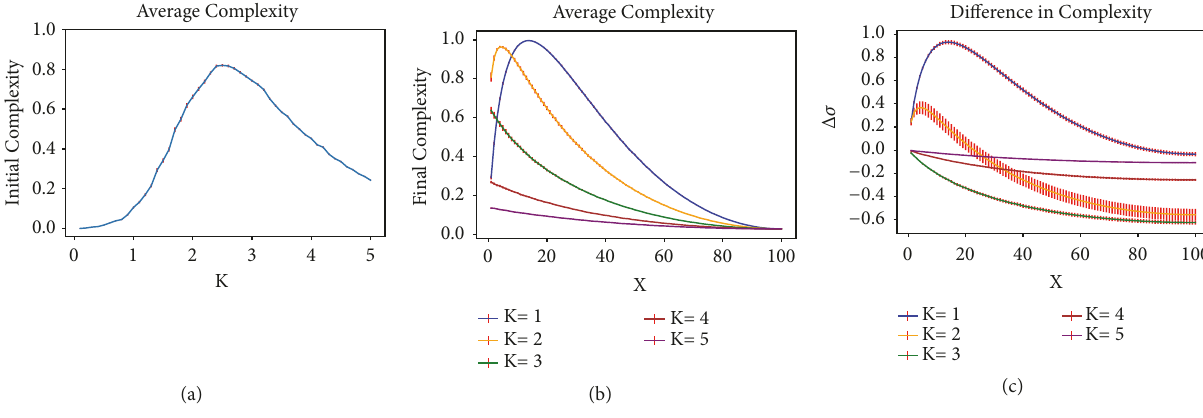
Figure 4: Initial and final complexity for 𝐾 = 1, 2, 3, 4, 5 with 𝑁 = 100. The error bars represent the standard error of measurements for 50 different networks at 10 different initial states run by 200 steps. (a) Complexity before adding perturbations. (b) Complexity after adding perturbations. (c) Difference of complexity before and after